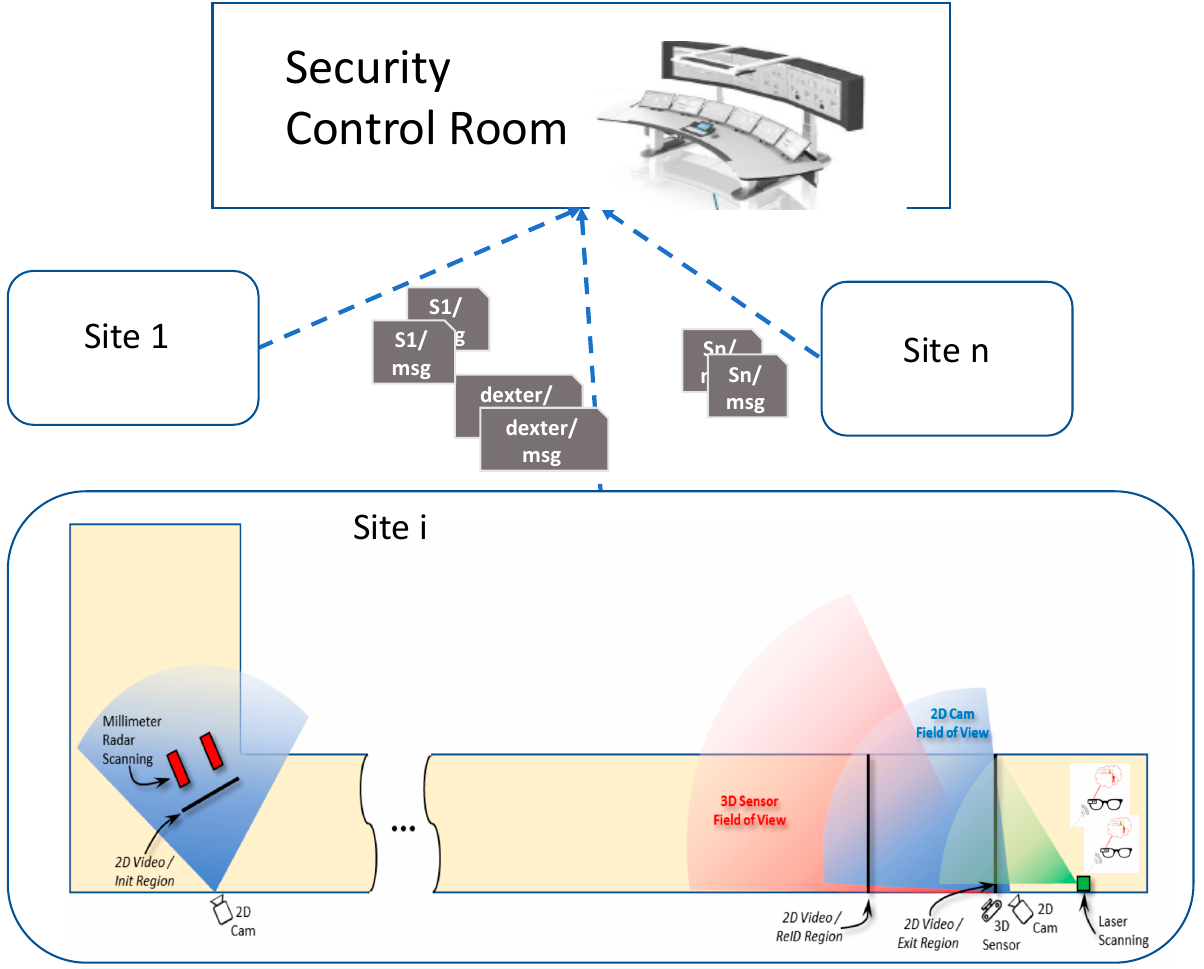
Figure 1. The C&C system deployed in a security control room at a critical infrastructure. The C&C receives messages from different sites. Site i displays the DEXTER deployment for the big city trial, as also shown in [7] .